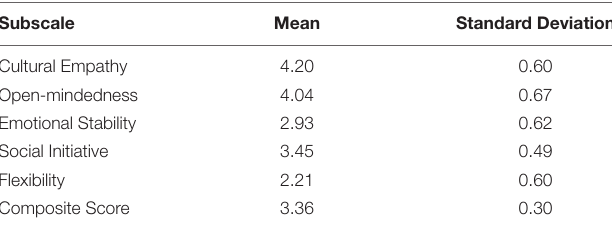
TABLE 1 | Means and standard deviations for multicultural personality questionnaire-short form.